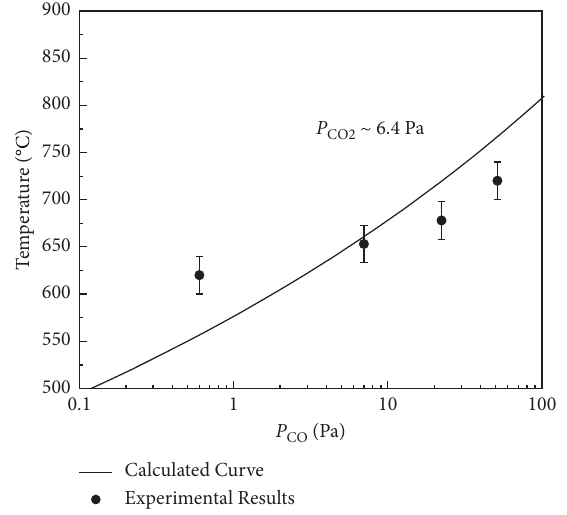
Figure 8: T � f ( P C CO ) for Incoloy 800H-experimental data and theory.